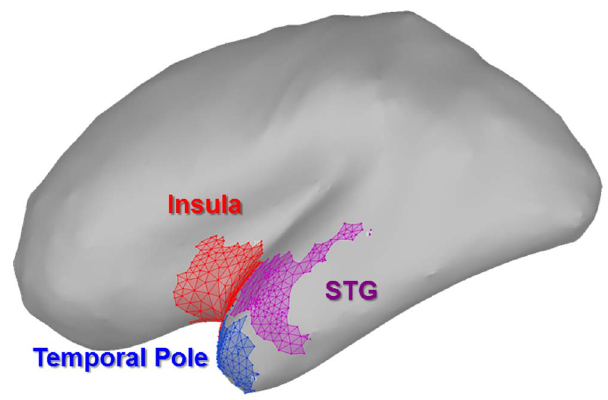
Figure 5. Regions identified as potentially contributing to signal observed in the amygdala. We used a rigorous and unbiased approach to identify potential sources of contamination. Of all the regions sampled, these are the only regions to potentially show evidence of gamma oscillations at , 170 ms. Therefore they were subjected to further